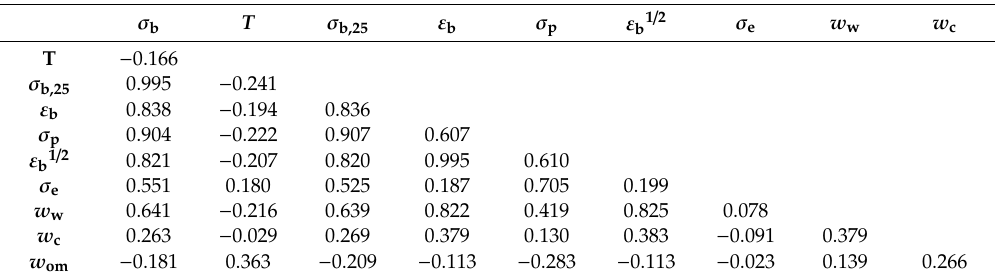
Table 10. Pearson’s product-moment correlation coe ffi cients among the WET-2 probe measurements and calculations and soil properties in the sites and depths the former were